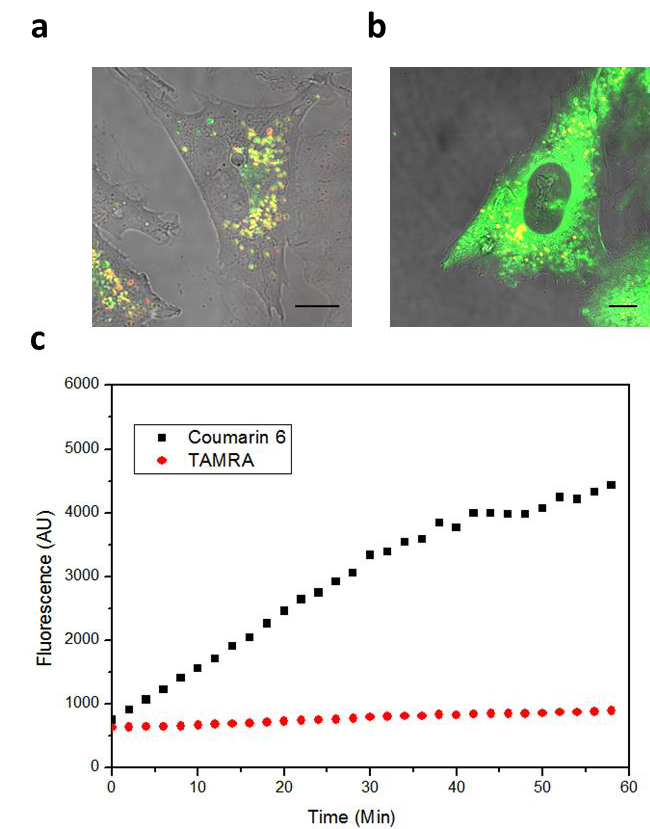
Figure 1. Nanoparticles internalization inside cells. ( a ) Intracellular distribution of Dend-NP shortly after (10 min) administration to the cells; ( b ) intracellular distribution of Dend-NP after 2 h; ( c ) Fluorescence increase of coumarin 6 (black) and carboxytetramethylrhodamine (TAMRA) (red) during the endocytosis process. Scale bar: 10 µm.